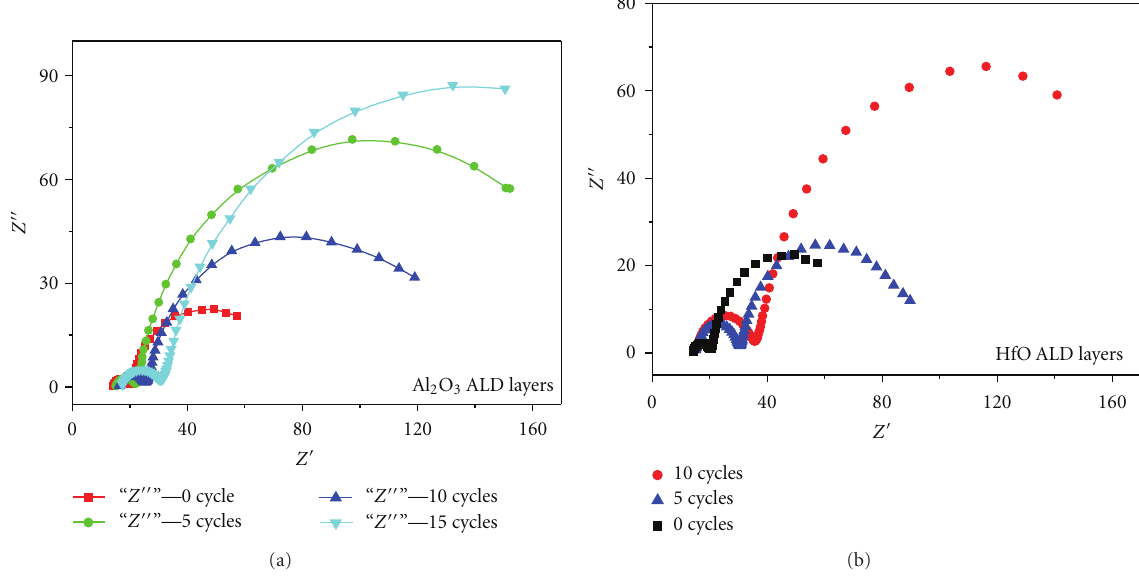
Figure 3: EIS spectra showing the Nyquist plots of the alumina ALD layers on Nb:TiO 2 DSC (a) and hafnia ALD layers on Nb :TiO 2 (b) for di ff erent